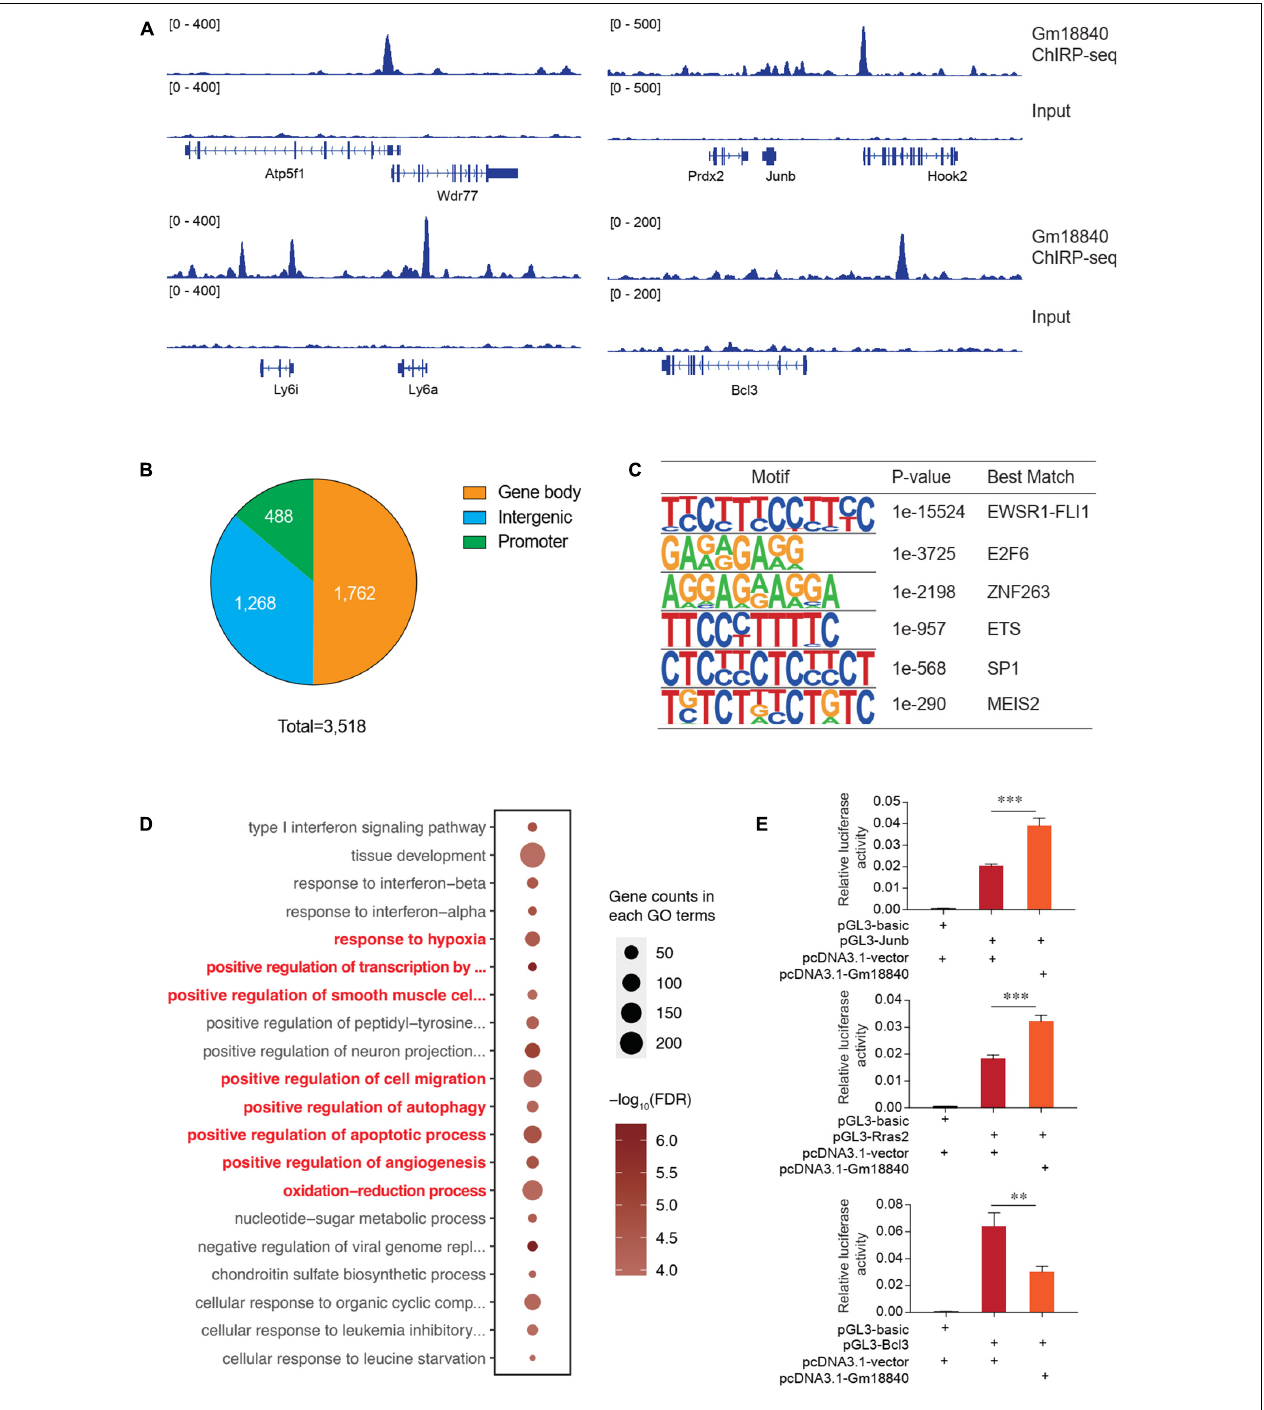
FIGURE 6 | Gm18840 is involved in transcriptional regulation in cardiac muscle cells. (A) Genome-browser screen showing the binding of Gm18840 in the regulatory regions of representative genes. ChIRP-seq experiments were conducted to determine the genome-wide binding of Gm18840 to chromatin. Representative binding among the regulatory regions of Wdr77, Junb, Ly6a, and Bcl3 is shown. (B) Distribution of Gm18840-bound regions. The numbers of Gm18840-bound peaks in the gene body, promoter, and intergenic regions are shown. (C) Motif analysis of Gm18840-bound regions. The motif analysis was performed with the Homer suite. The EWSR1-FLI1, E2F6, ZNF263, ETS, SP1, and MEIS2 motifs were highly enriched, implying the coregulation of Gm18840 with these factors. (D) Gene ontology analysis of genes associated with Gm18840-bound peaks. (E) Gm18840 directly regulated the transcriptional activity of its targets. Luciferase reporter assays were performed in HL-1 cells. The representative regions bound by Gm18840, including Junb, Rras2, and Bcl3, were cloned into the pGL3 plasmid. The luciferase constructs were cotransfected with the pcDNA3.1 vector or pcDNA3.1-Gm18840 plasmids. The firefly luciferase activity was normalized to Renilla luciferase activity. ** p < 0.01 and *** p < 0.001.